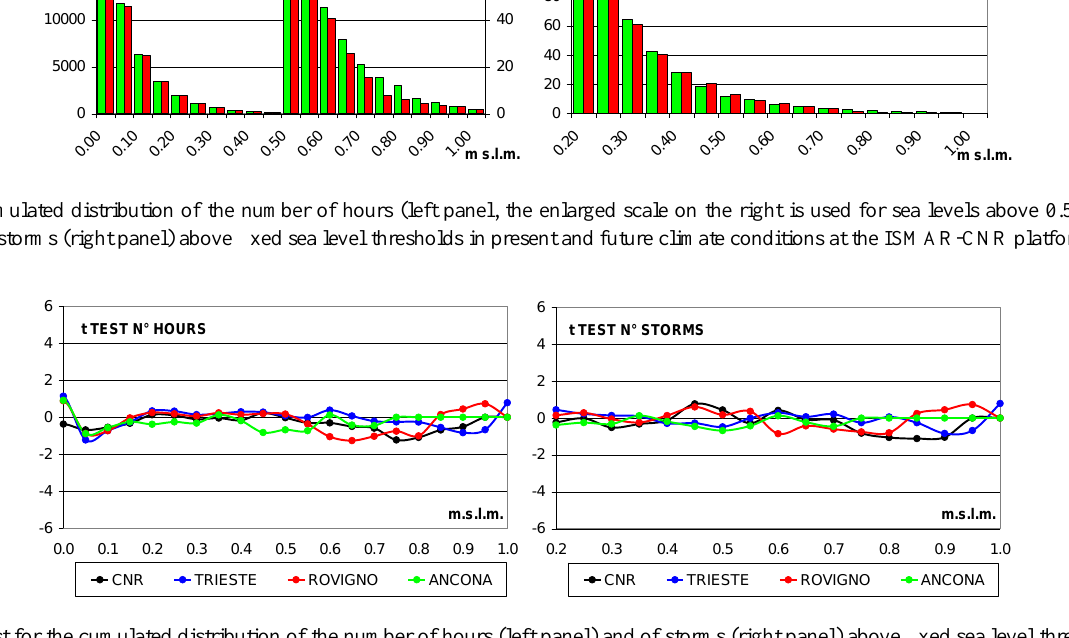
Figure 9. t-test for the cumulated distribution of the number of hours (left panel) and of storms (right panel) above fixed sea level thresholds at the four locations shown in Figure 1a.